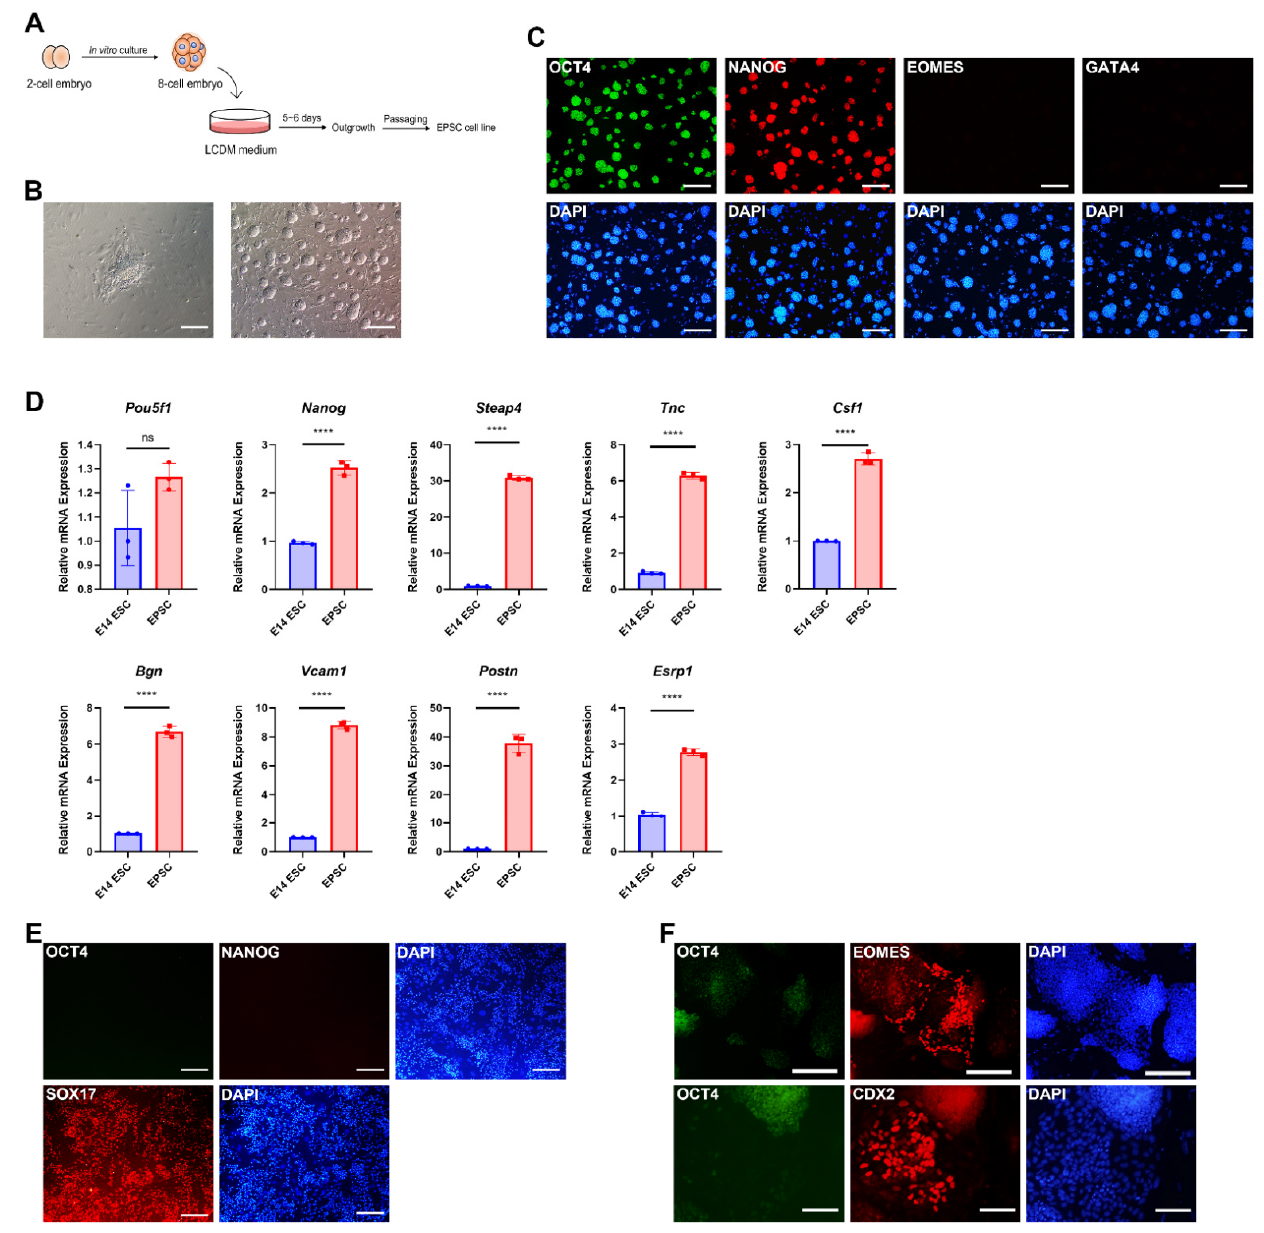
Figure 1. Establishment and characterization of extended pluripotent stem cells (EPSCs). ( A ) Schematic illustration for the establishment of EPSC lines from 8-cell embryos. ( B ) Representative images of 8-cell-stage embryo 5 days after seeding (left) and established EPSCs at passage 3 (right). Scale bars: 200 µm. ( C ) Immunocytochemistry images of EPSCs. EPSCs are shown to express pluripotency markers OCT4 and NANOG, whereas extraembryonic markers EOMES and GATA4 are not expressed. Scale bars: 200 µm. ( D ) quantitative RT-PCR analysis of EPSCs and ESCs about EPSC-specific upregulated genes. Data are presented as the mean ± SD for n = 3 independent experiments and every dot indicates the expression value of each sample. Gapdh was used as a housekeeping gene. EPSCs displayed a strong expression of genes that are overexpressed in EPSCs compared to ESC, as previously published. Student’s t -test: ns, non-significant; **** p < 0.0001. ( E , F ) Immunochemistry images of XEN ( E ) and TSC populations ( F ) directly converted from EPSCs. EPSC-derived XEN cells express primitive endoderm marker SOX17 (red) without expression of pluripotency marker OCT4 (green). Scale bars: 200 µm. TSCs converted from EPSCs were shown to express EOMES and CDX2 (red), but not OCT4 (green). Nuclei were stained by DAPI (blue). Scale bars: 200 µm (EOMES), 100 µm (CDX2).